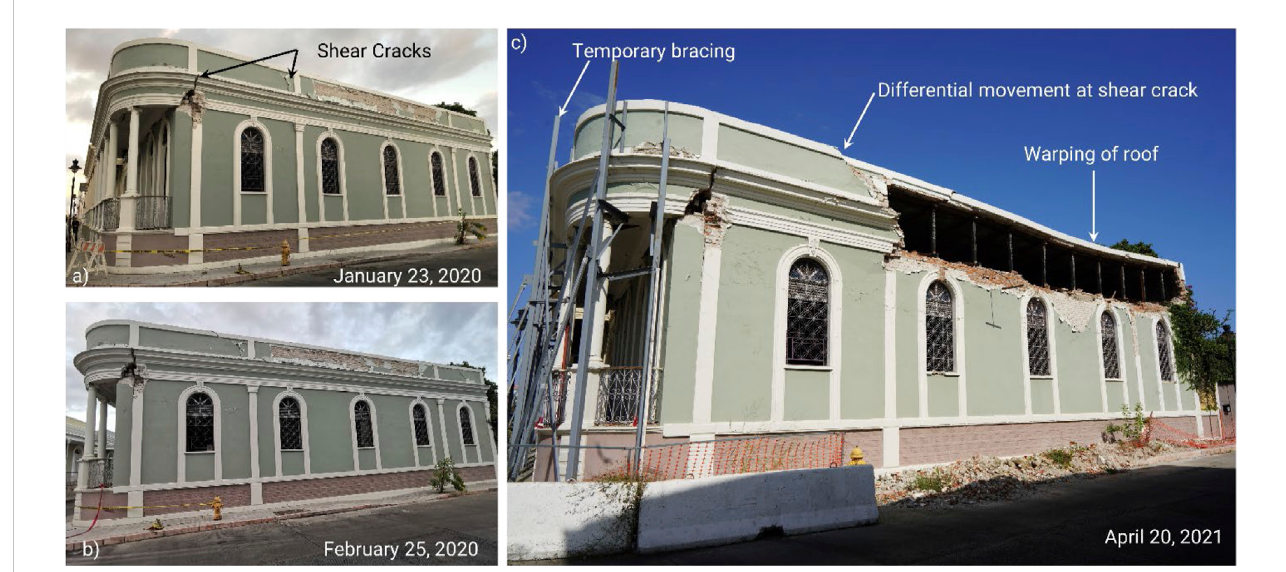
FIGURE 4 Damage progression of sample historical building in downtown Ponce under aftershock events. Images were taken during consecutive visits on (A) 23 January 2020, (B) 25 February 2020, and (C) 20 April 2021.